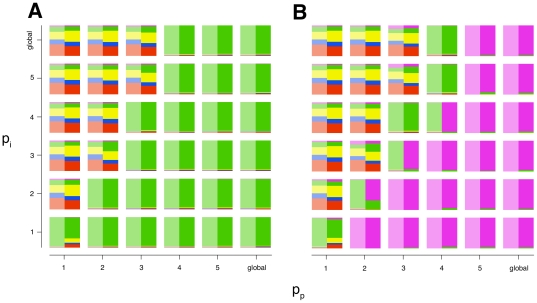
Strategy Frequencies for Non-Global Games.Results from the mathematical model (semi-transparent) and computational simulations (non-transparent) for non-global games with only first order punishment (
A
) and with second order punishment allowed (
B
). Note the similar phase transitions in non-global games. Color code as in Figure 1.